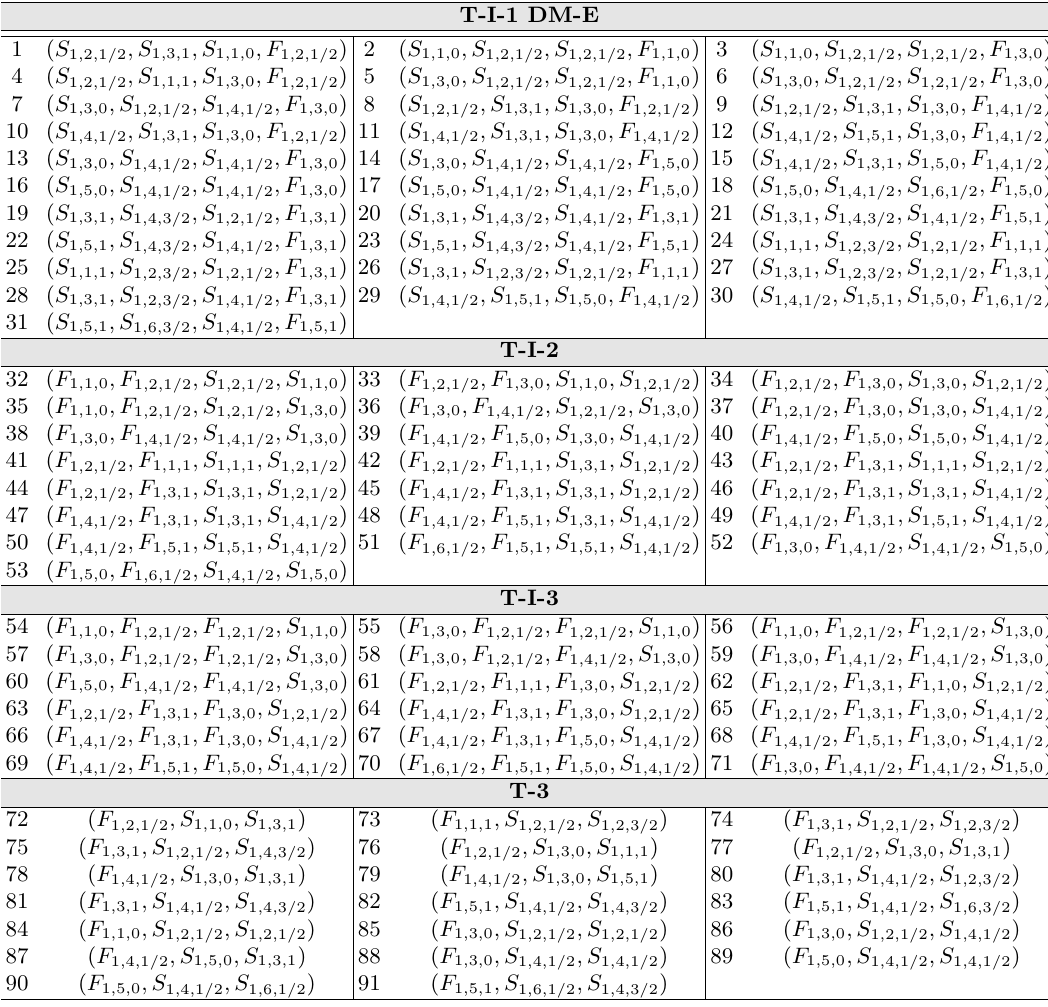
Table 8 . DM models with exits (DM-E) which need a stabilizing symmetry to give an acceptable WIMP